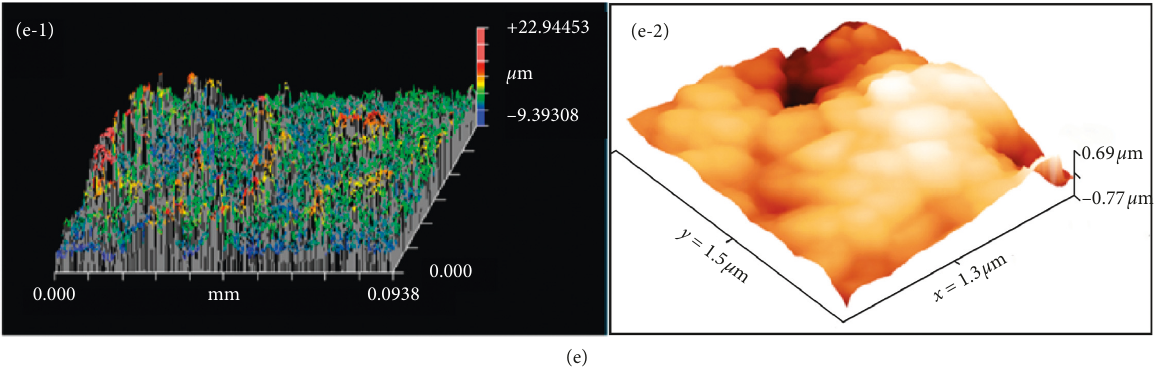
Figure 2: The 3D topography of (a) M-Al, (b) MN-Al, (c) M-SS, (d) MN-SS, and (e) N-SS surface.